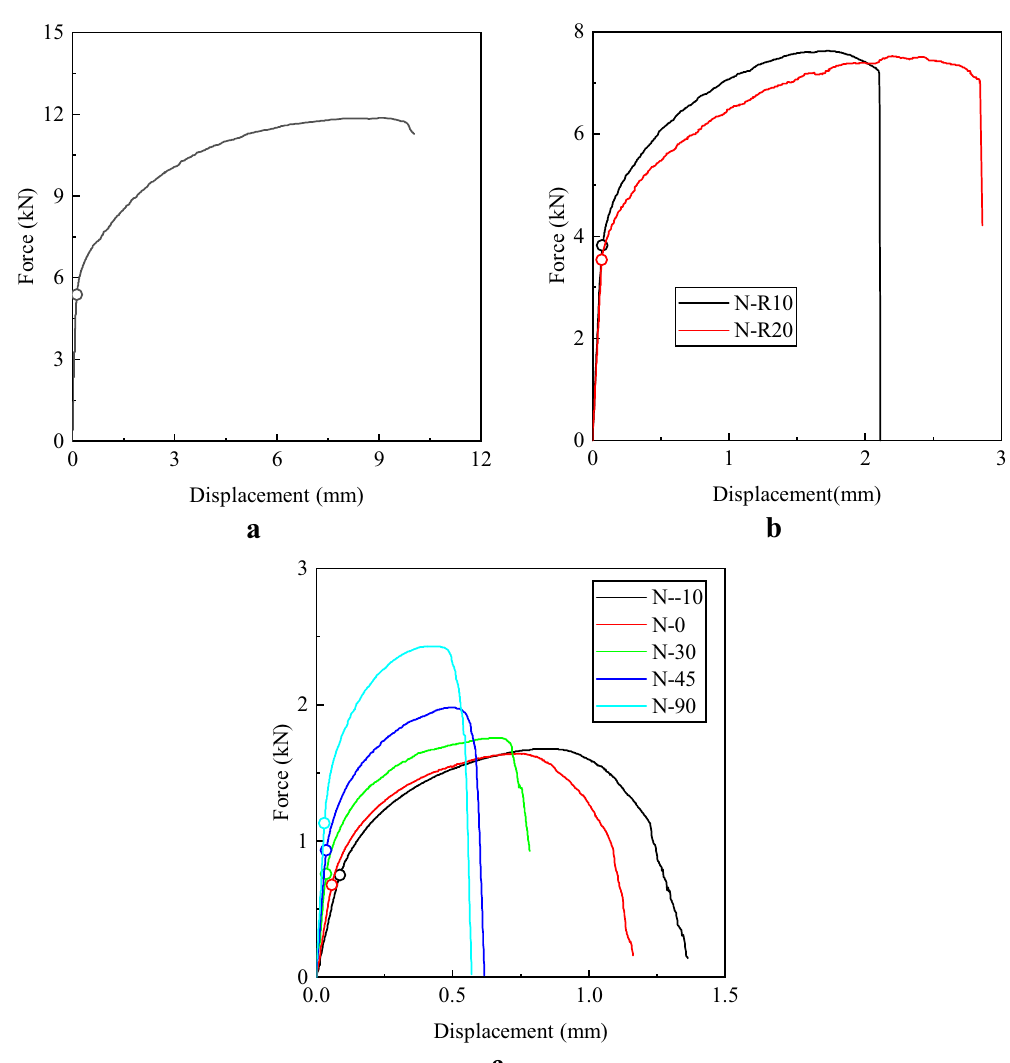
Figure 2 Tensile force–displacement curves of experiments: a standard tensile specimen, b specimens with arc–shaped notches and c specimens with sharp–angled